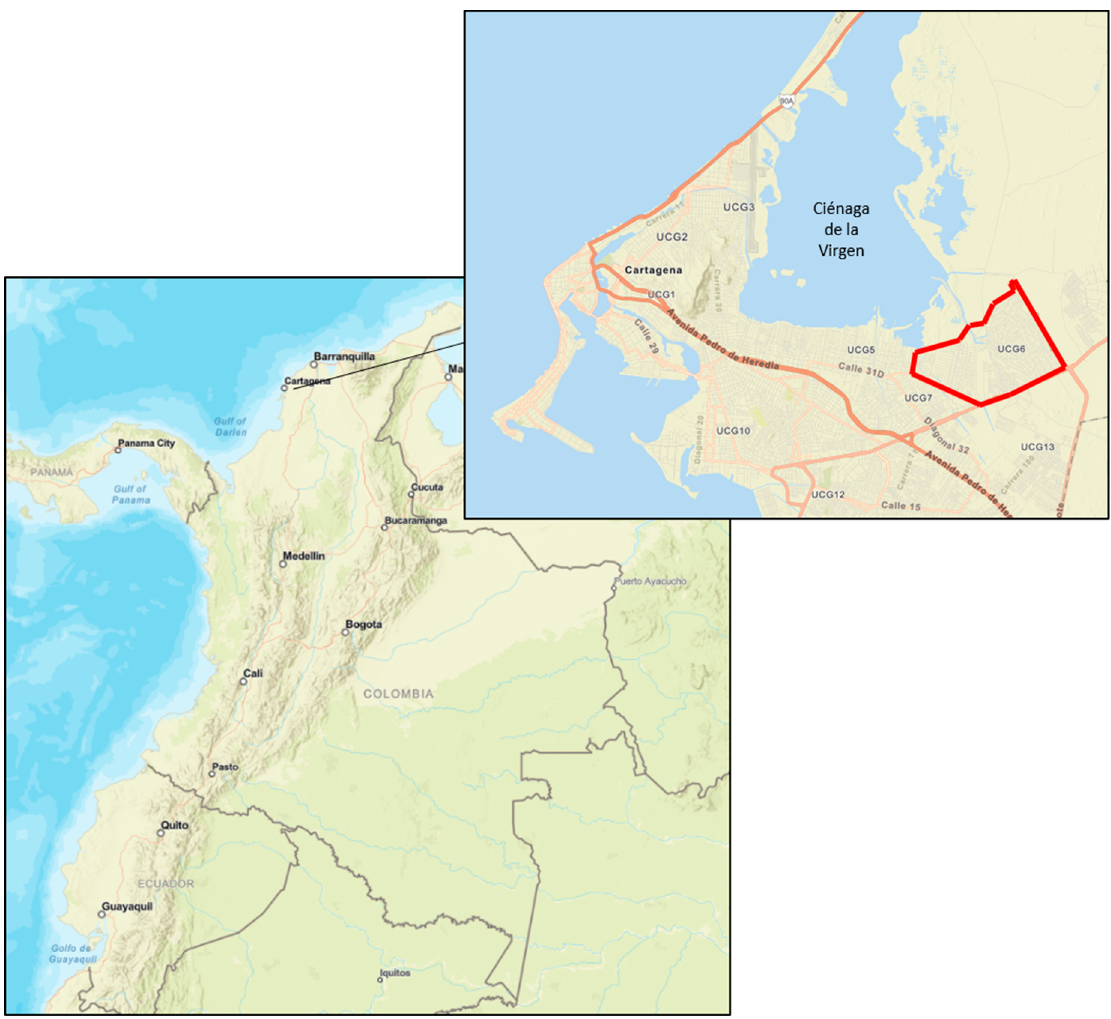
Figure 3. Location of field sites (in red) in Cartagena, Colombia (Adapted from) [33] (mapa digital de Colombia).